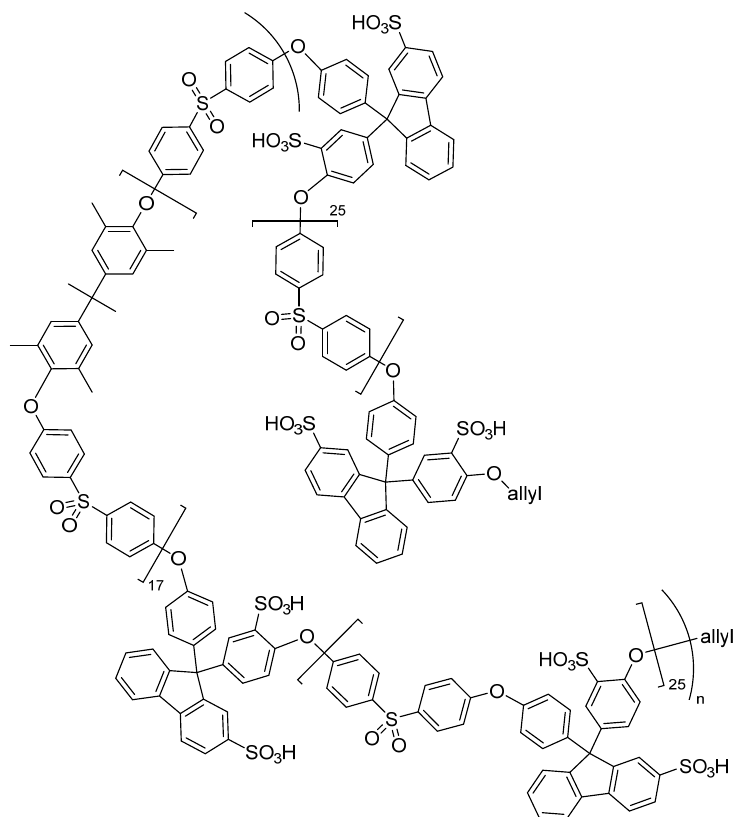
Figure 8. Structure of the sulfonated poly(ether sulfone) (SPES) ‐ based ionomeric block copolymer with terminal allyl groups for crosslinking.